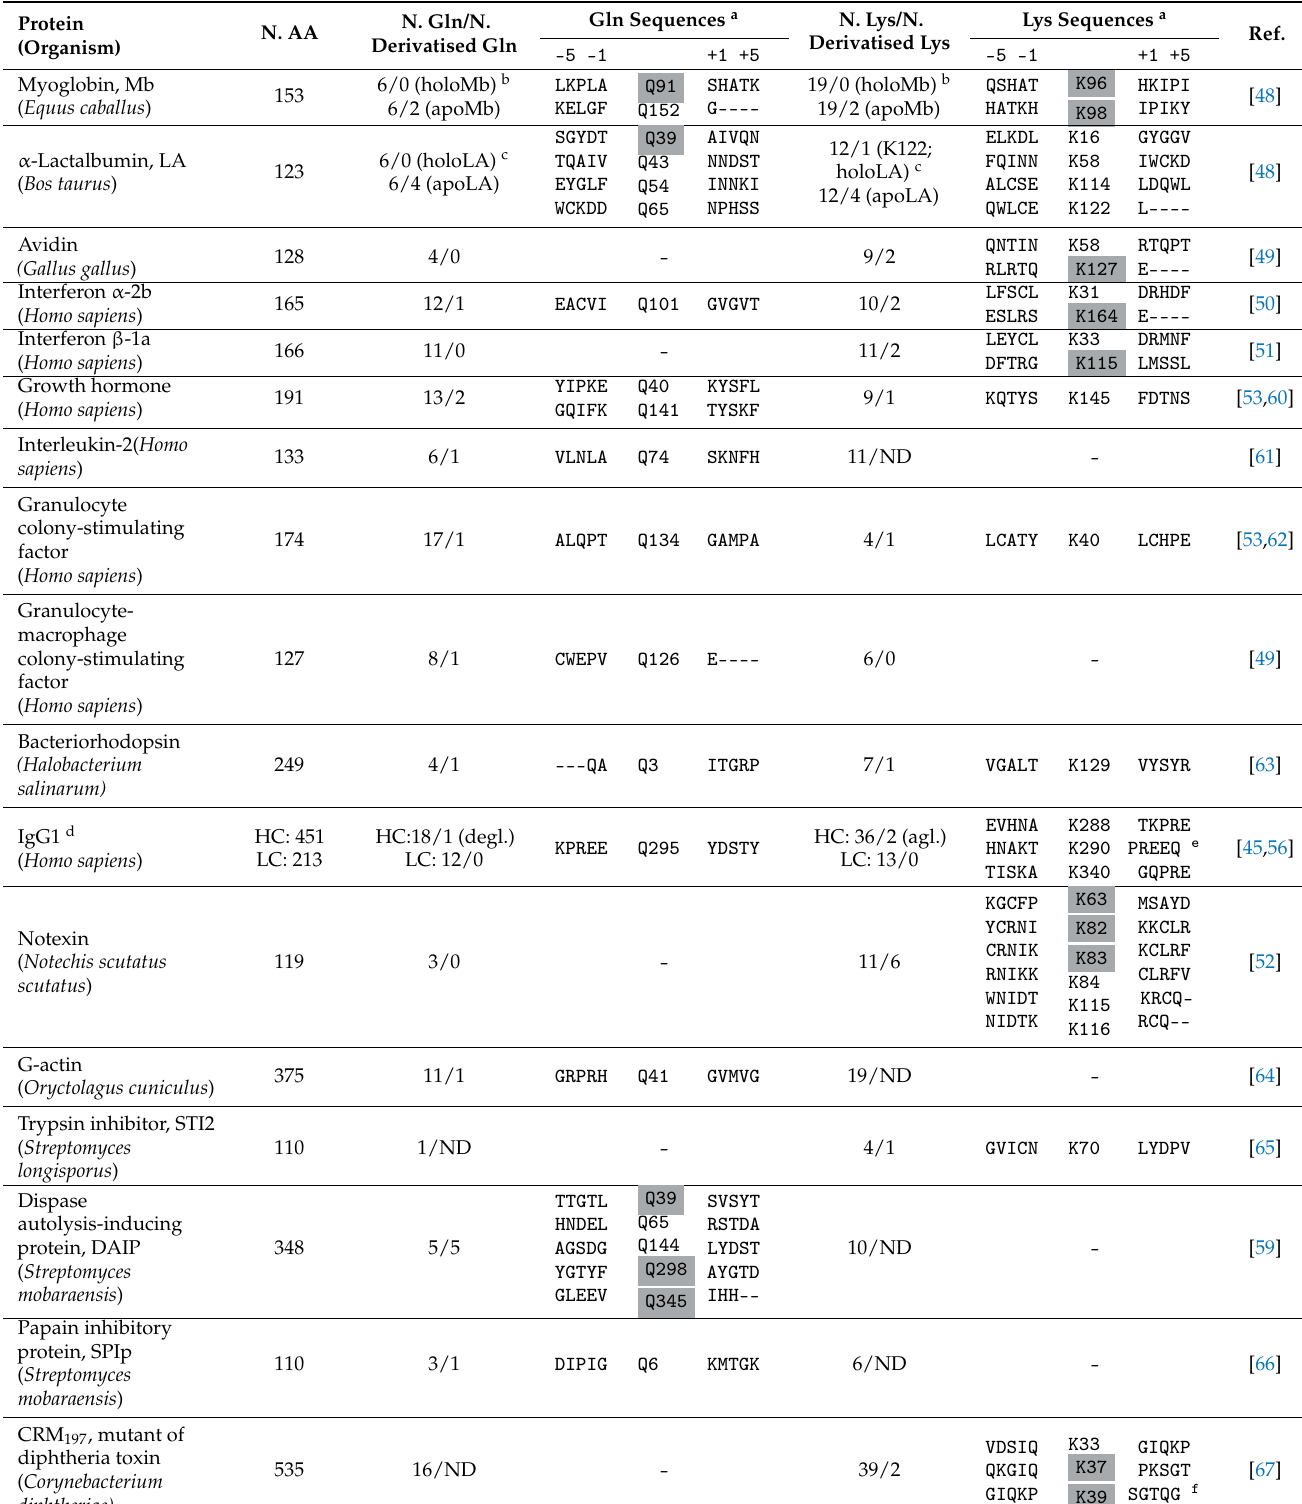
Table 4. Examples of sites of mTG-mediated derivatization in